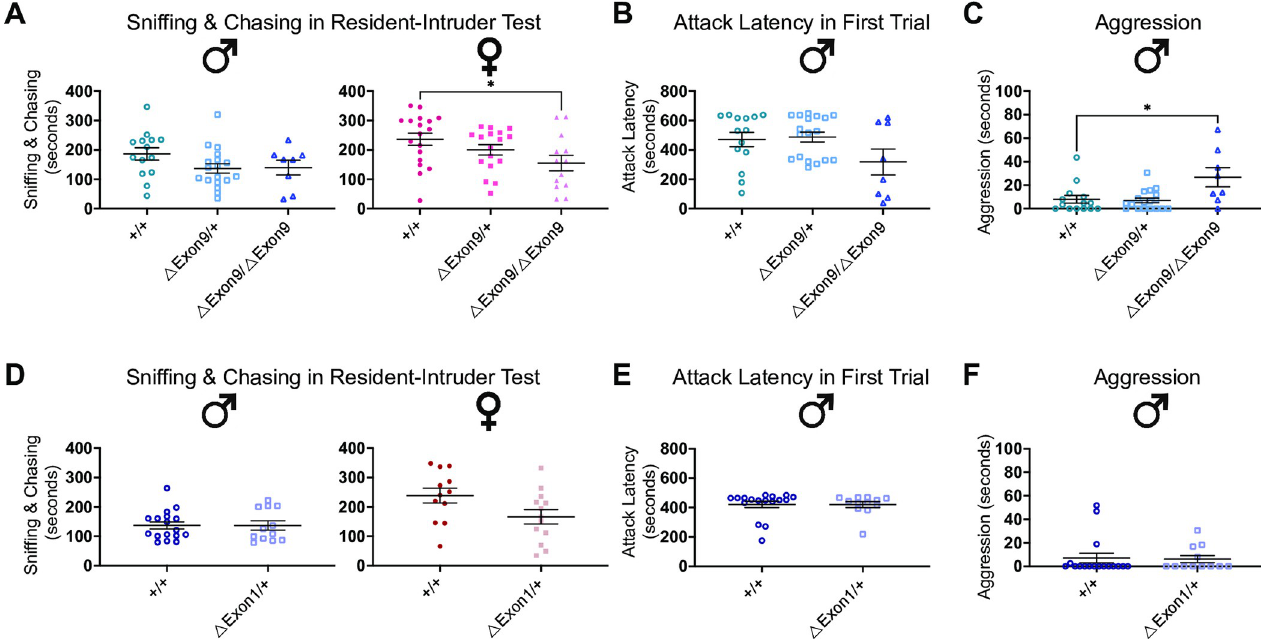
Fig 3. Complete loss of Nrxn1 α expression enhances aggressive behaviors in males and reduces passive interactive behaviors in females. A-C. No genotype difference was observed in time spent sniffing and chasing the intruder mouse (A, left) or for attack latency (B) among Δ Exon9 males. Δ Exon9/ Δ Exon9 female mice show reduced time sniffing and chasing the intruder mouse (A, right). Δ Exon9/ Δ Exon9 male mice exhibit increased aggressive behaviors compared to +/+ males (C). Male +/+, n = 14; male Δ Exon9/+, n = 18; male Δ Exon9/ Δ Exon9, n = 8; female +/+, n = 18; female Δ Exon9/+, n = 17; female Δ Exon9/ Δ Exon9, n = 13. The data were analyzed using one-way ANOVA test with Tukey’s multiple comparison test. D-F. No genotype difference was observed in time spent sniffing and chasing the intruder mouse among Δ Exon1 males (left) and females (right) (D), for attack latency (E) or for exhibiting aggressive behaviors among Δ Exon1 males (F). The number of animals used for each group in this test is the same as those in Fig 2C and 2D. Data were analyzed using Mann-Whitney U test. For all panels in Fig 3, data are represented as mean ± SEM; � p < 0.05.